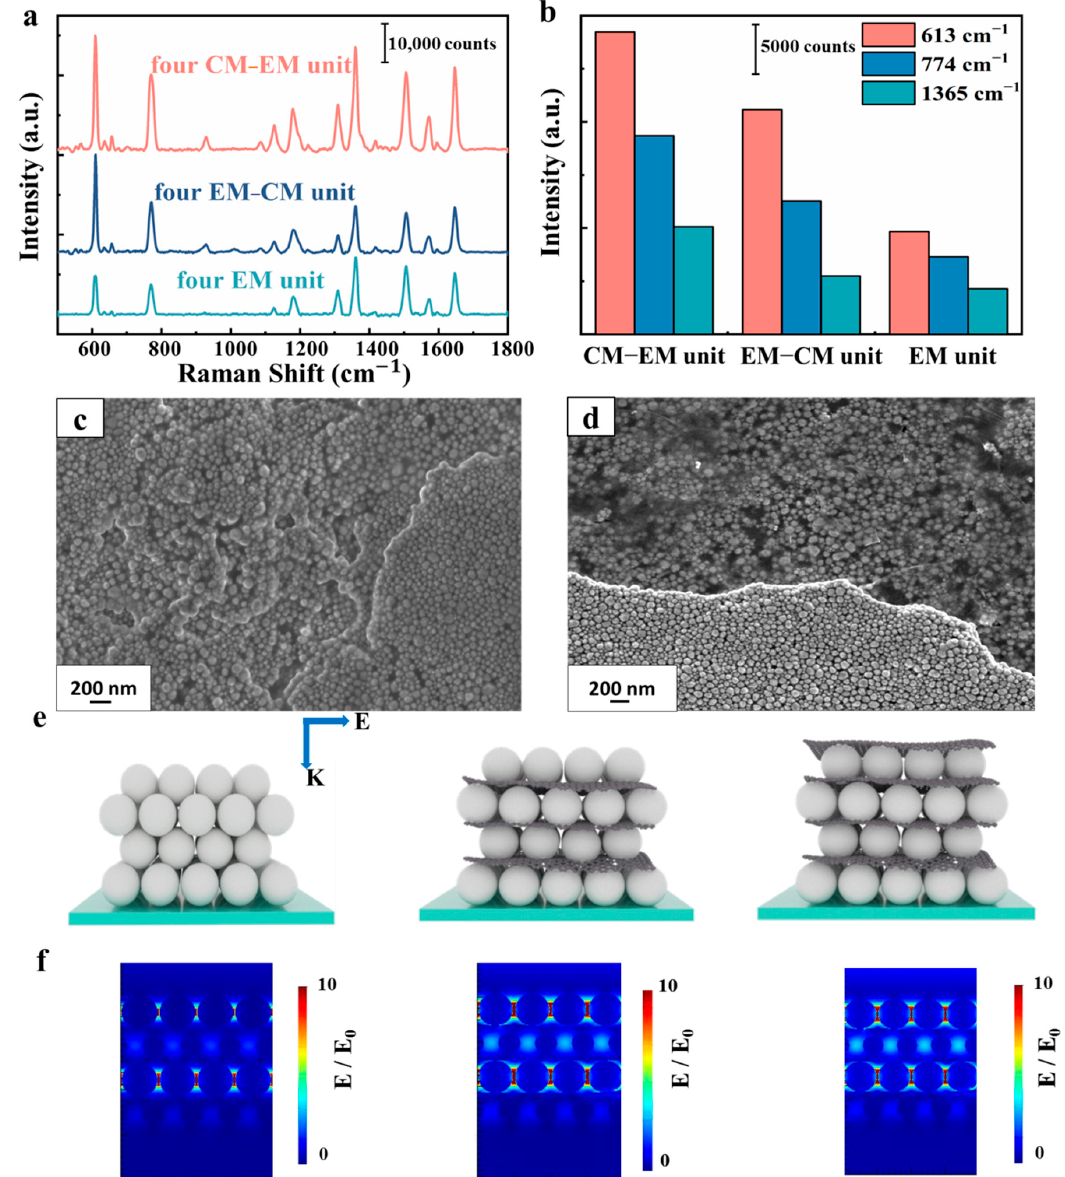
Figure 7. ( a ) Raman spectra of R6G with concentration of 10 − 6 M obtained from four EM unit substrates, four EM–CM unit substrates, and four CM–EM unit substrates. ( b ) Raman signal intensity of R6G at 613, 774, and 1365 cm − 1 peaks. SEM images of ( c ) four EM unit substrates and ( d ) four EM–CM unit substrates. ( e ) Simulation set-up of four EM unit substrates, four EM–CM unit substrates, and four CM–EM unit substrates. ( f ) The x-z views of electric field distribution of different SERS substrates at 532 nm wavelength.